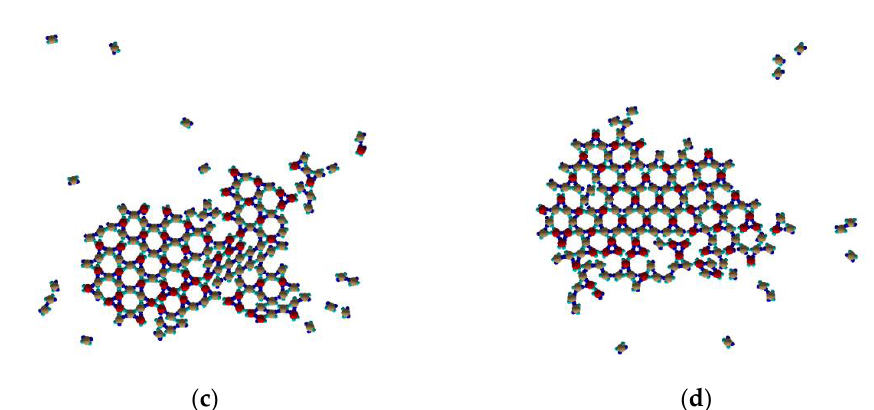
Figure 6. Sequence of steps of the Kagome cocrystal formation, concentration type I:type II = 1:2, T* = 0.10: ( a ) after 3.0E5 MC steps; ( b ) after 8.0E6 MC steps; ( c ) after 2.2E7 MC steps; ( d ) after 5.9E7 MC steps.